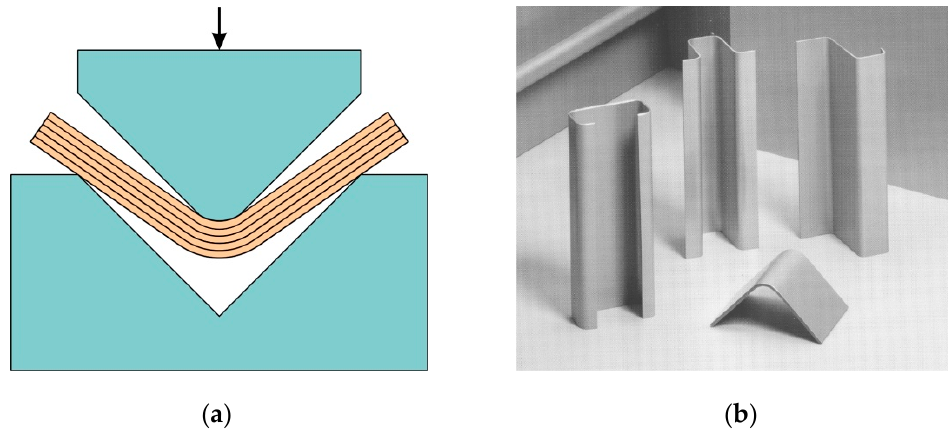
Figure 4. ( a ) schematic diagram of PBB and ( b ) examples of FML components produced by PBB (reproduced with permission from [213]; copyright© 2021 Woodhead Publishing Limited).